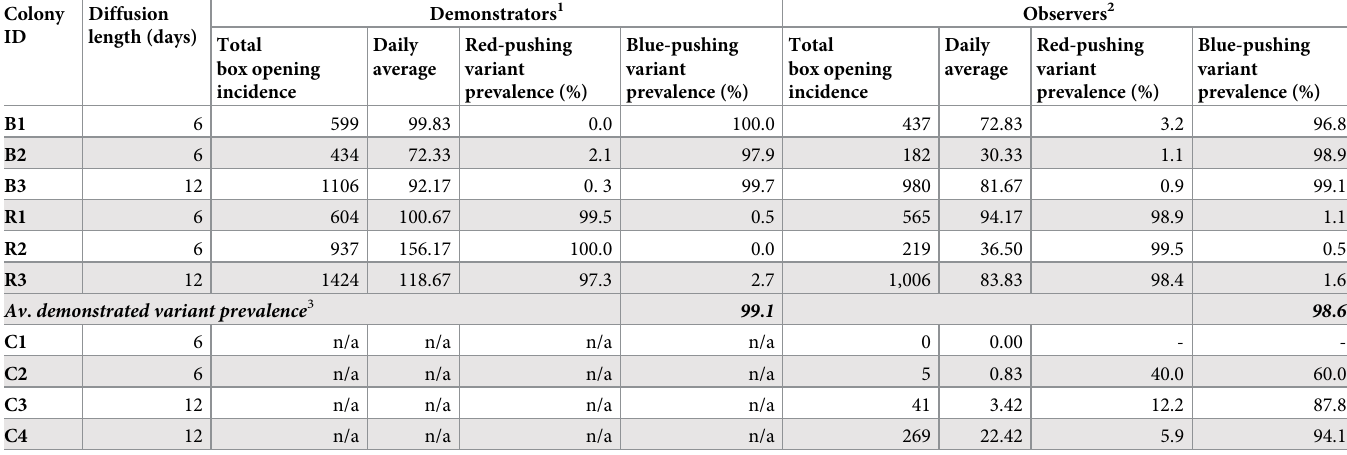
Table 2. Preferences for puzzle box-opening behavioural variants in the single-demonstrator diffusion experiments. Colony Diffusion ID length